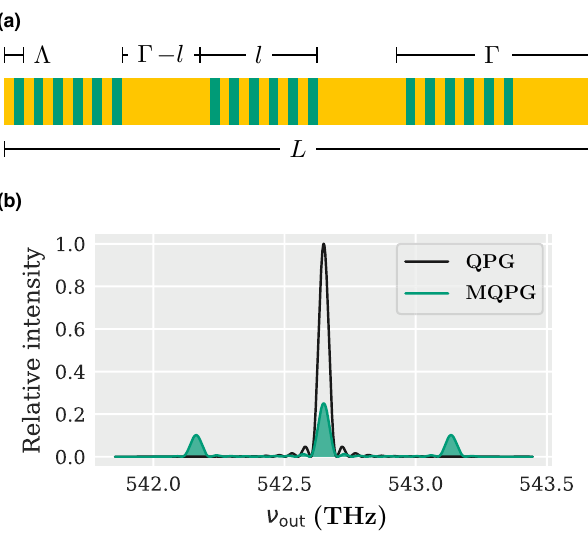
FIG. 2. (a) The superpoling pattern of an MQPG waveguide: regions of length l poled with period (cid:5) are alternating with unpoled regions of length (cid:6) − l , where (cid:6) is the period of this alternation. The regions corresponding to the standard nonlinear- ity coefficient of the waveguide are shown in yellow, whereas those corresponding to the reversed nonlinearity coefficient are represented in green. (b) A simulation of the phase-matching intensity spectrum of a MQPG (green) compared with that of a QPG (black). The lower efficiency of a MQPG can be compensated with use of higher pump powers.